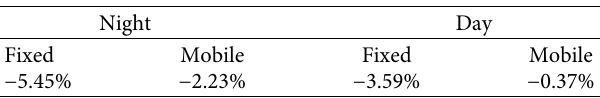
Table 5: Comparison of change in the accident likelihood by a 1 m 2 increase in the hazard size.